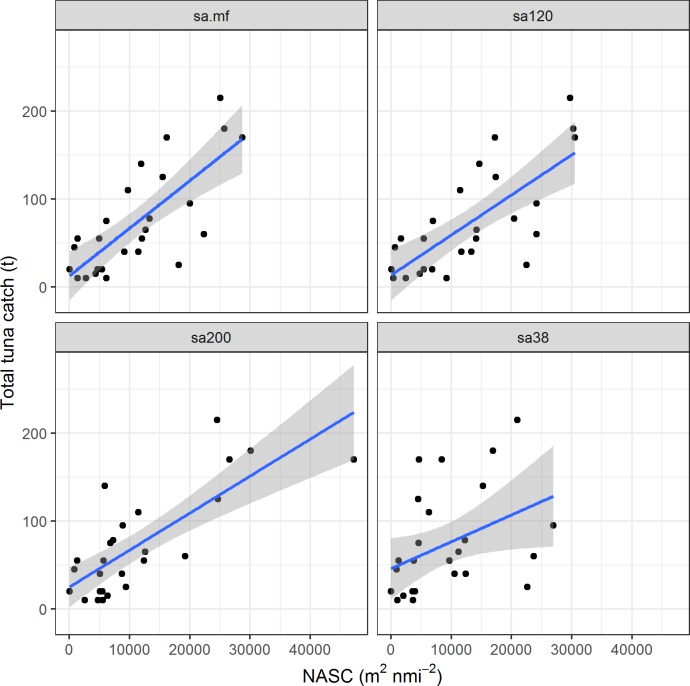
Scatterplot of total catch against (a) NASCMF, (b) NASC120, (c) NASC200 and (d) NASC38.